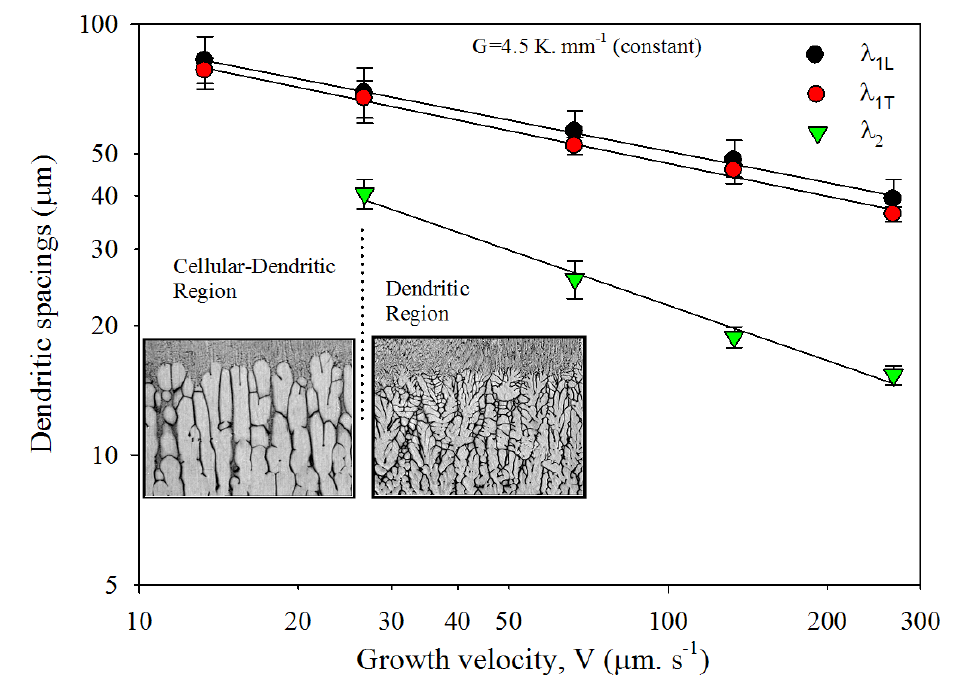
Figure 5. The variation of PDAS and SDAS with growth velocity at a constant temperature